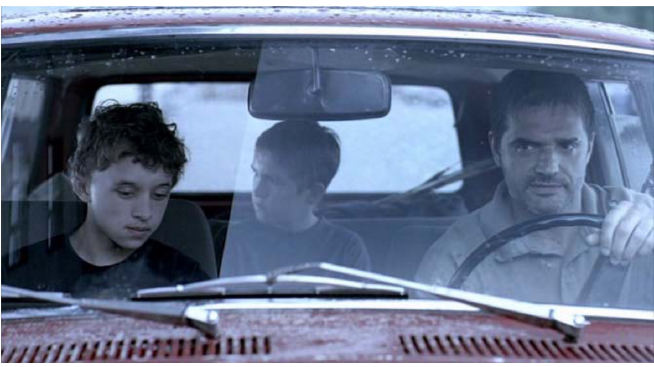
Figure 4. The Return (2003).